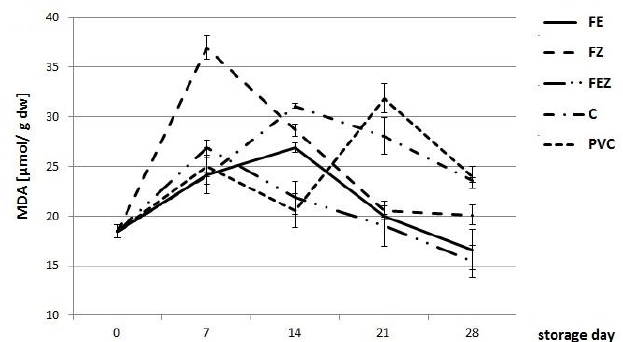
Figure 4. Malondialdehyde (MDA) content of white button mushrooms packed in different active packages containing zeolite (FZ), aҫai extract (FE), aҫai extract + zeolite (FEZ) packed in MAP, without active packaging in MAP (C) or wrapped in polyvinyl chloride foil (PVC) measured on each storage day. Standard error is presented in a form of horizontal bars.